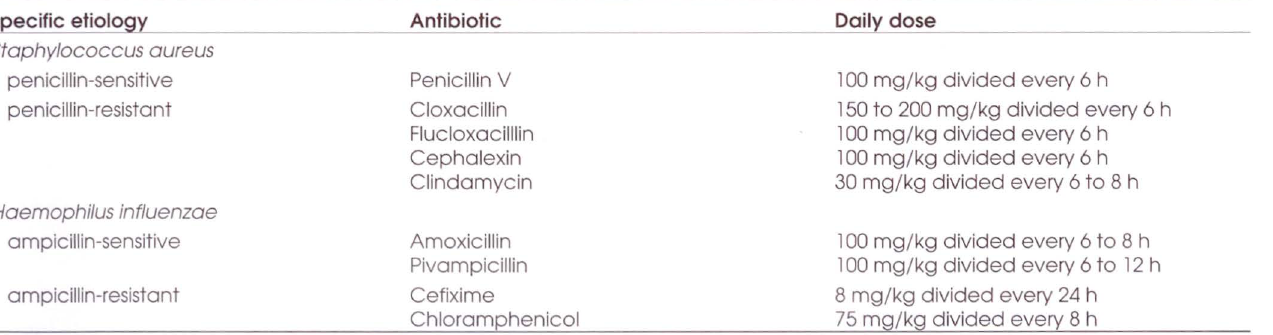
Choice of oral antibiotics for completing therapy of acute hematogenous bone or joint infections in children Staphylococcus